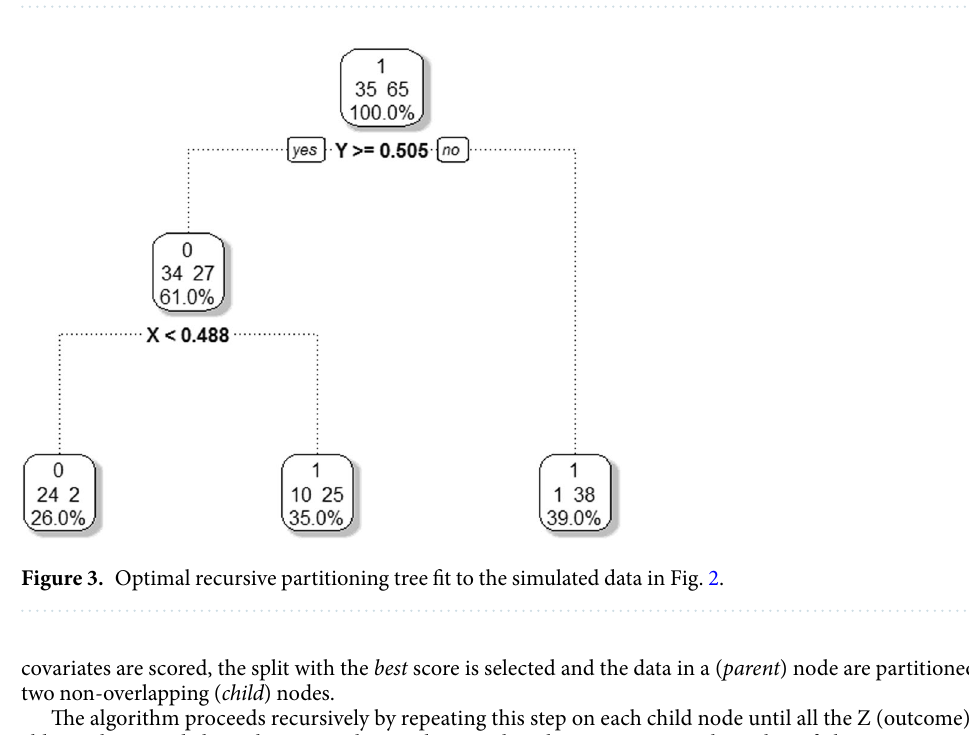
Figure 2. Simulated data to illustrate classical recursive partitioning.